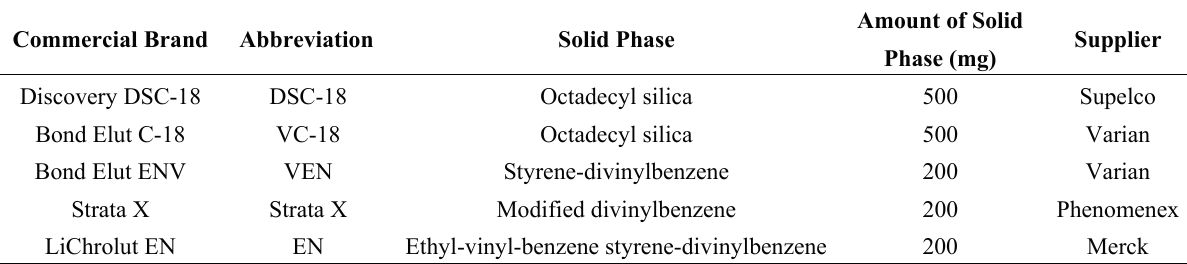
Table 4. Characteristics of evaluated solid phase extraction (SPE)